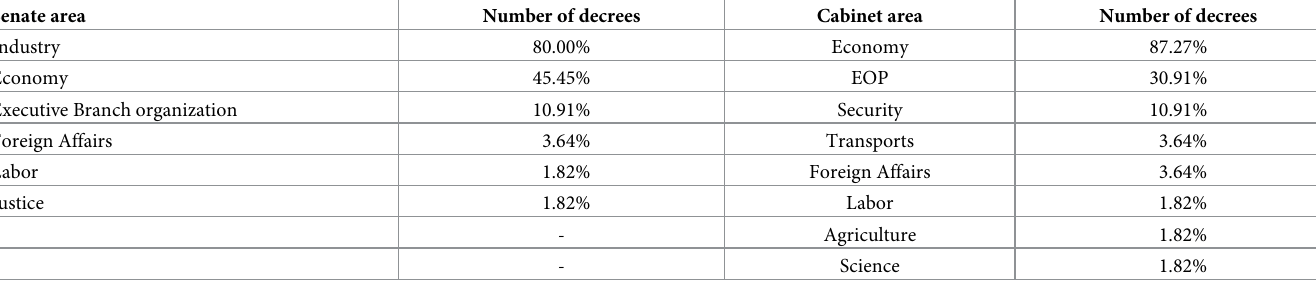
Table 12. PAC cluster: Senate and cabinets taxonomies. Areas that are not present in this cluster were omitted. Senate